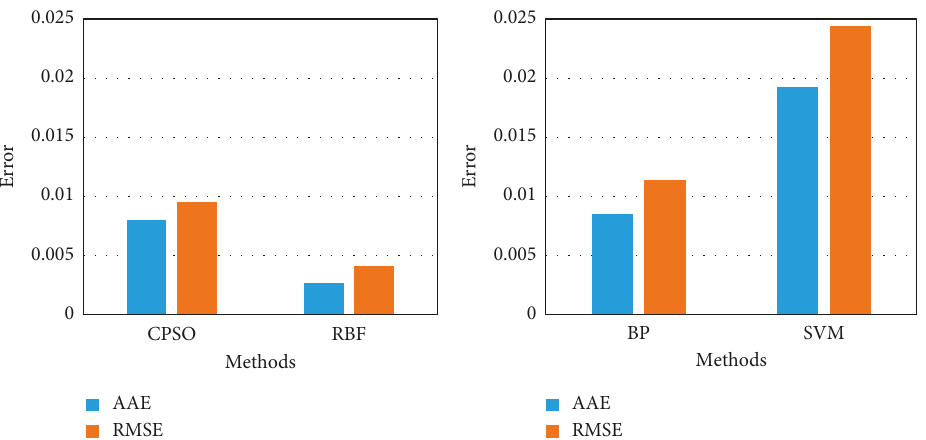
Figure 7: Error comparison of four kinds of neural networks.